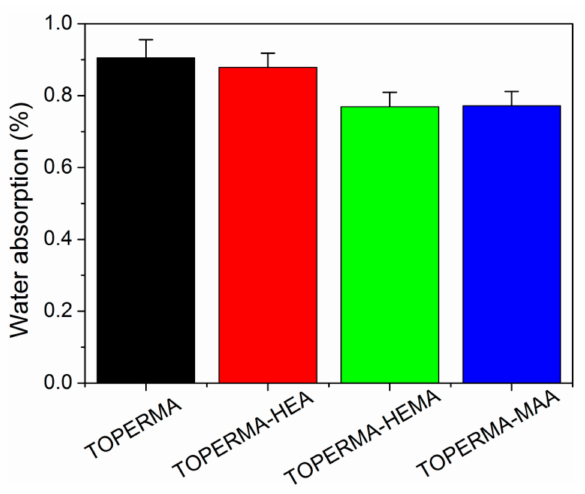
Figure 6. Water absorption of the cured TO-based